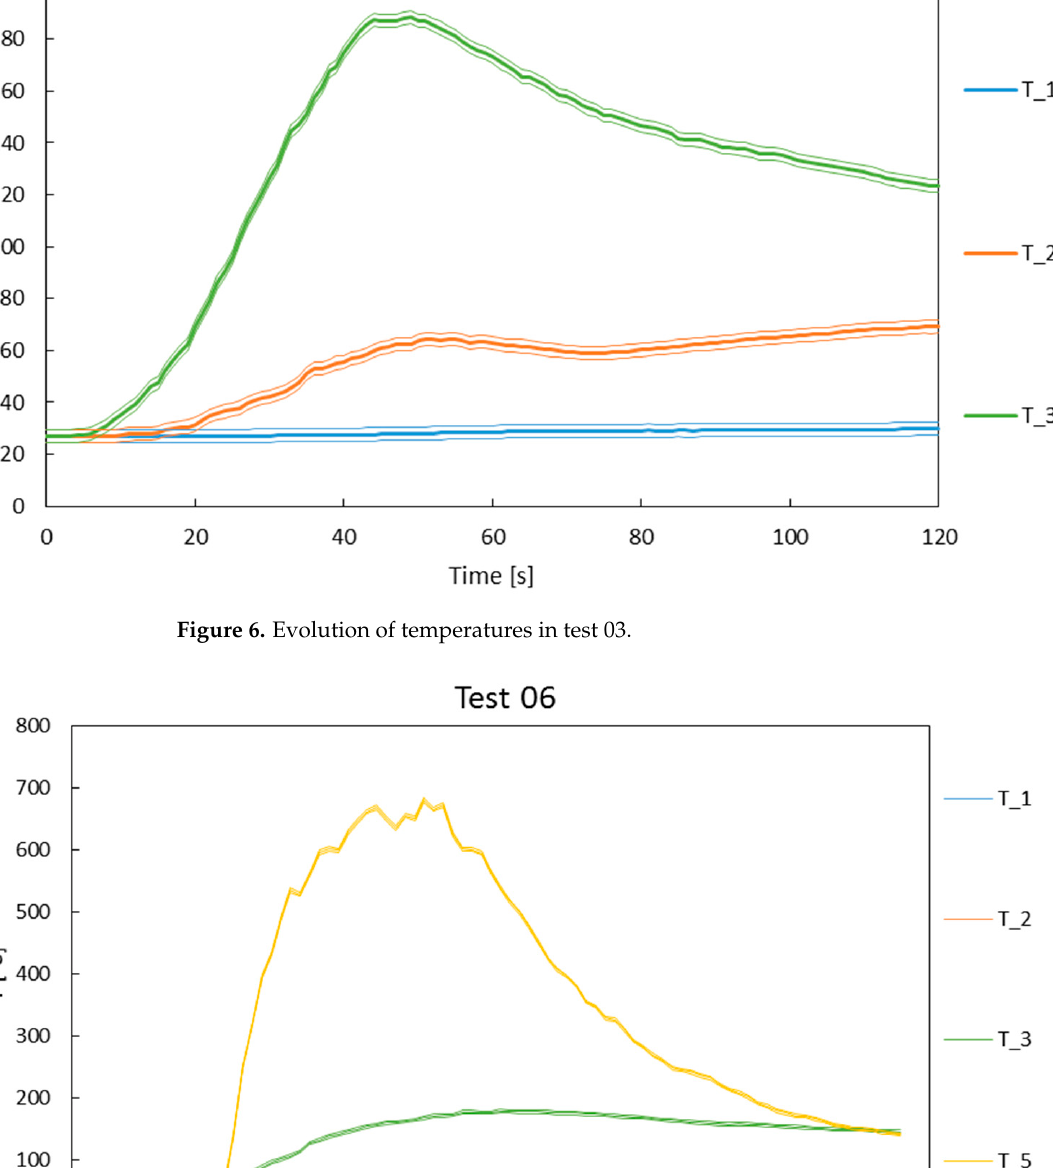
Figure 8. Evolution of temperatures in Test 11. Figures 9 and 10 show the fire front shape evolution for 5 s time steps for the tests with 3 m·s − 1 wind speed, protection installed, without sidewalls and with sidewalls (tests 03 and 06, respectively).